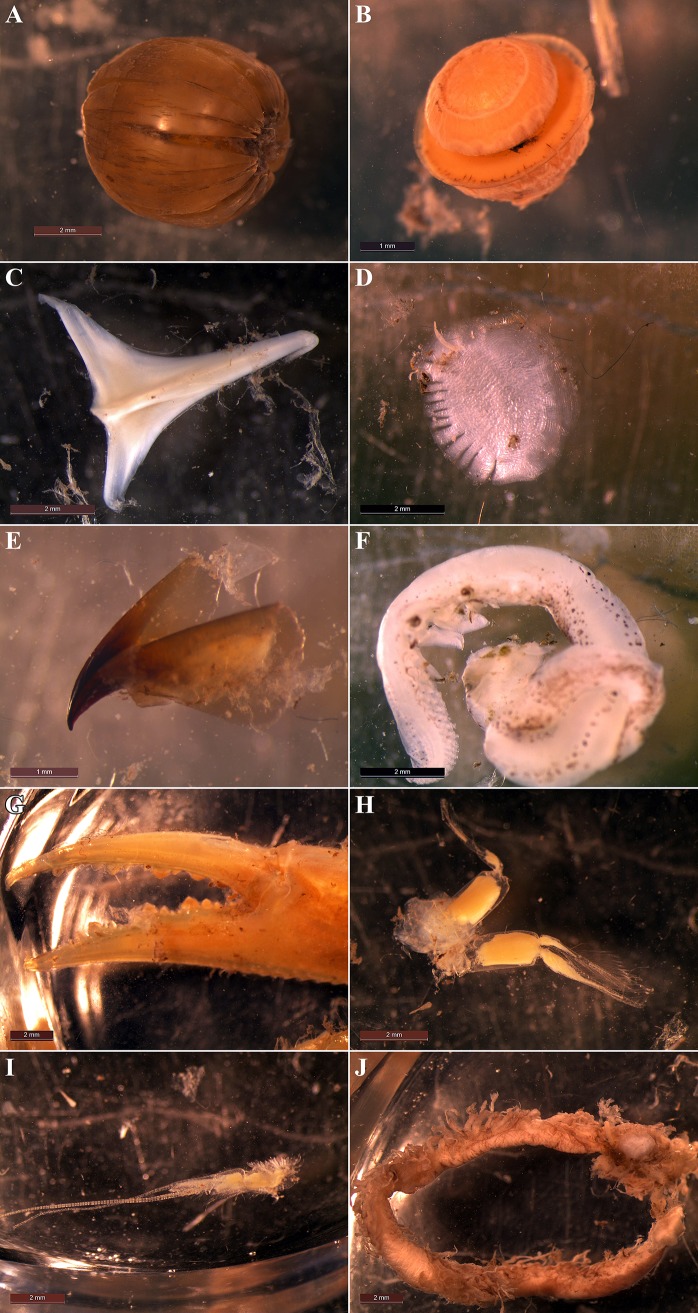
Bythaelurus stewarti n. sp., paratype, ZMH 26252, female, 295 mm TL, stomach contents.(A) partially digested teleost fish eye, (B) cephalopod eye, (C) probably a teleost bone but possibly a lophophore structure instead, (D) teleost scale, (E) beak of cephalopod Ancistrocheirus cf. lesueurii, (F) arm of cephalopod Ancistrocheirus cf. lesueurii, (G) decapod (probably brachyuran) claw, (H) antennae of a swimming decapod of the paraphyletic suborder “Natantia”, (I) antennulae of a swimming decapod of “Natantia”, (J) unidentified food remains, possibly a partially digested shrimp stomach.